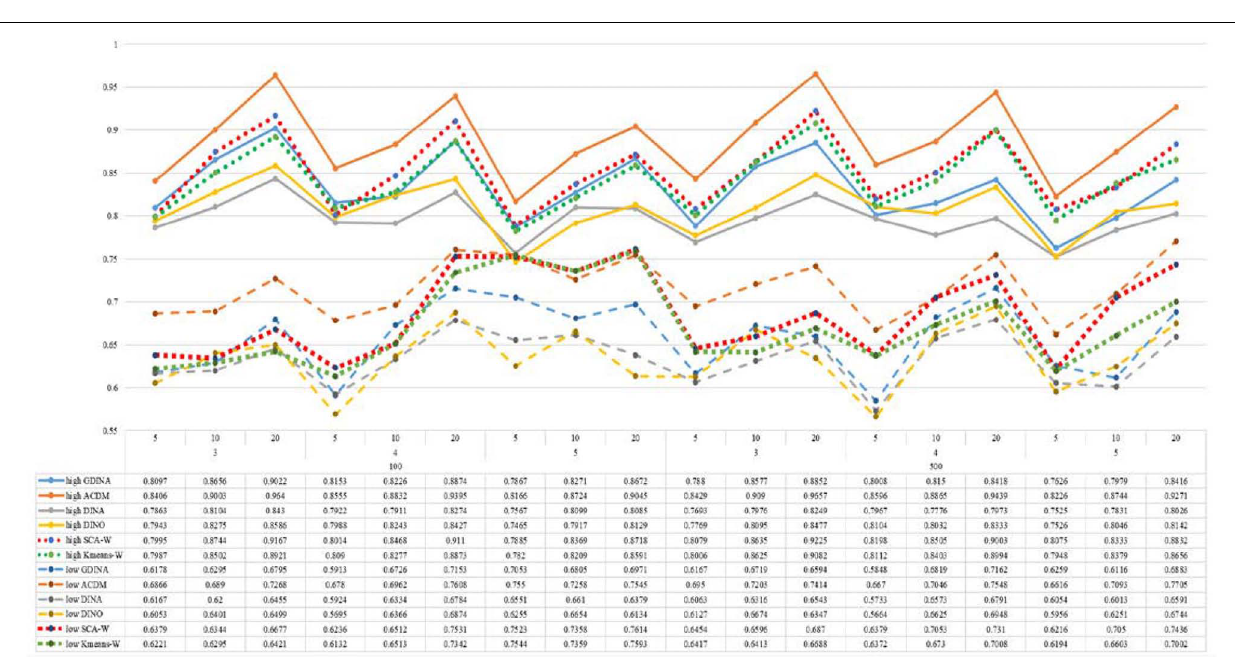
FIGURE 4 | Mean values of ω by SCA, K-means, and fitted models; True model = A